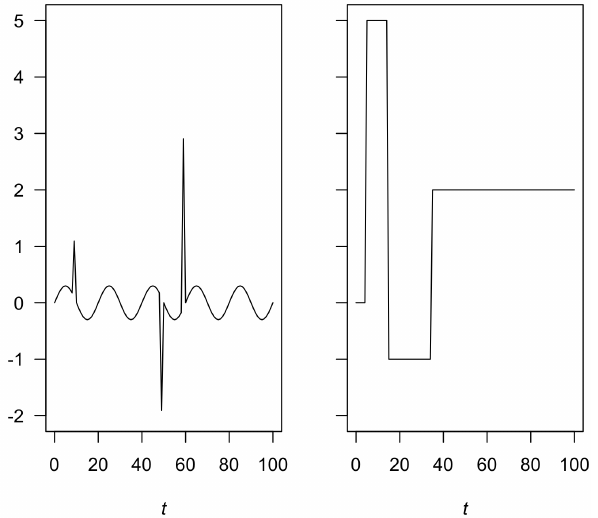
Figure 1. Left panel: simulated functional part for the peaks 0.1,0.5 and 0.6. Right panel: example for K = 4 randomly simulated means, considering the constraints of distance of at least three to the peaks and a minimum length of